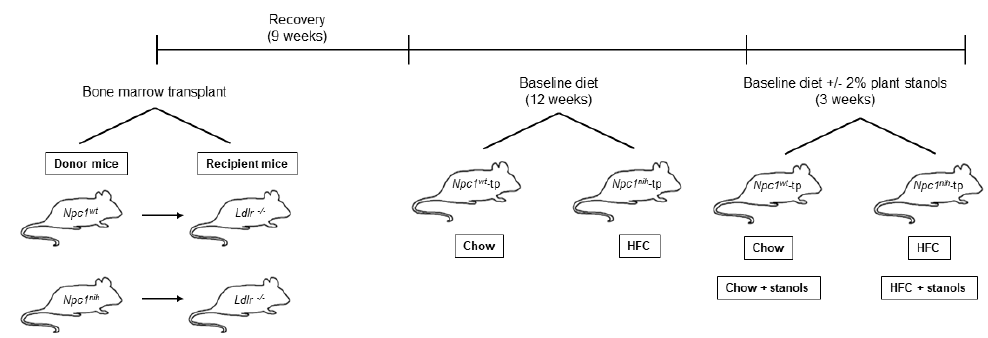
Figure 1. Overview of study setup and timeline. Ldlr − / − mice received a bone marrow transplant from Npc1 nih or Npc1 wt mice. After recovery, Npc1 wt -tp and Npc1 nih -tp mice received a cholesterol-poor chow or HFC diet for 12 weeks. On the final three weeks of the study period, their diet was supplemented with 2% plant stanols.